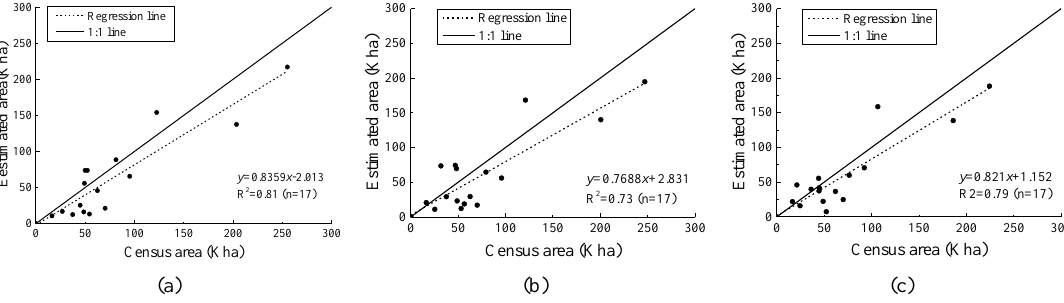
Figure 13. Comparison of CSRA-estimated oilseed rape acreages and agricultural census data at the municipal level in ( a ) 2014; ( b ) 2015; and ( c )